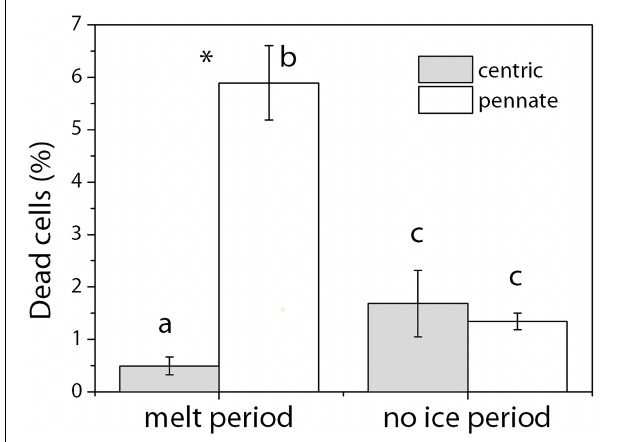
FIGURE 2 | Percentage of dead cells (%) in the diatom community during the melt period and the no-ice period. Cells in water samples were stained with the LIVE/DEAD TM BacLight TM stain (Thermo Fisher Scientific, Inc., United States), filtered onto black 25 mm polycarbonate membrane filters (0.2 µ m in pore size, Whatman Nuclepore TM , United Kingdom), and analyzed with an epifluorescence microscope (BZ-9000, KEYENCE, Japan). Gray, centric diatoms; White, pennate diatoms. Mean values ( ± SD) are the average of four independent measurements. Alphabets indicate significant difference among different diatom groups. Stars indicate significant differences between the two incubation periods. ANOVA was used for comparisons. The significance level was